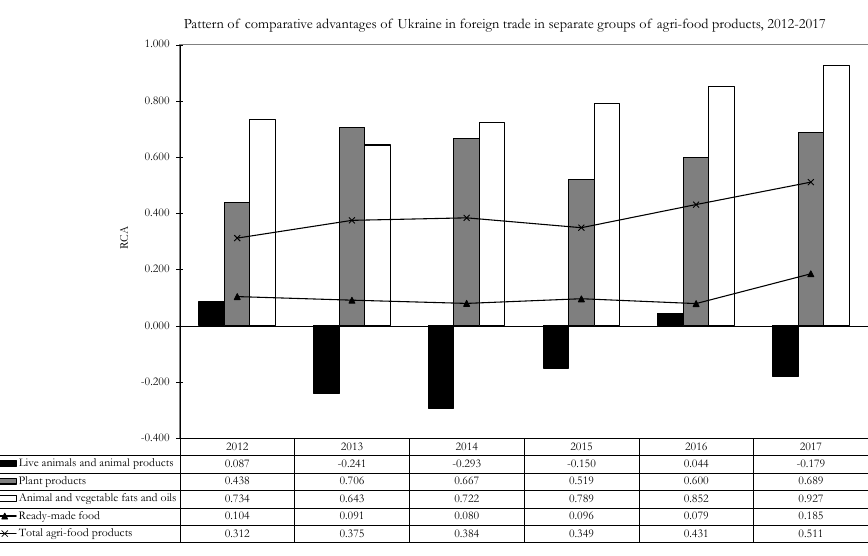
Fig. 1 – Pattern of comparative advantages of Ukraine in foreign trade in separate groups of agri-food products,